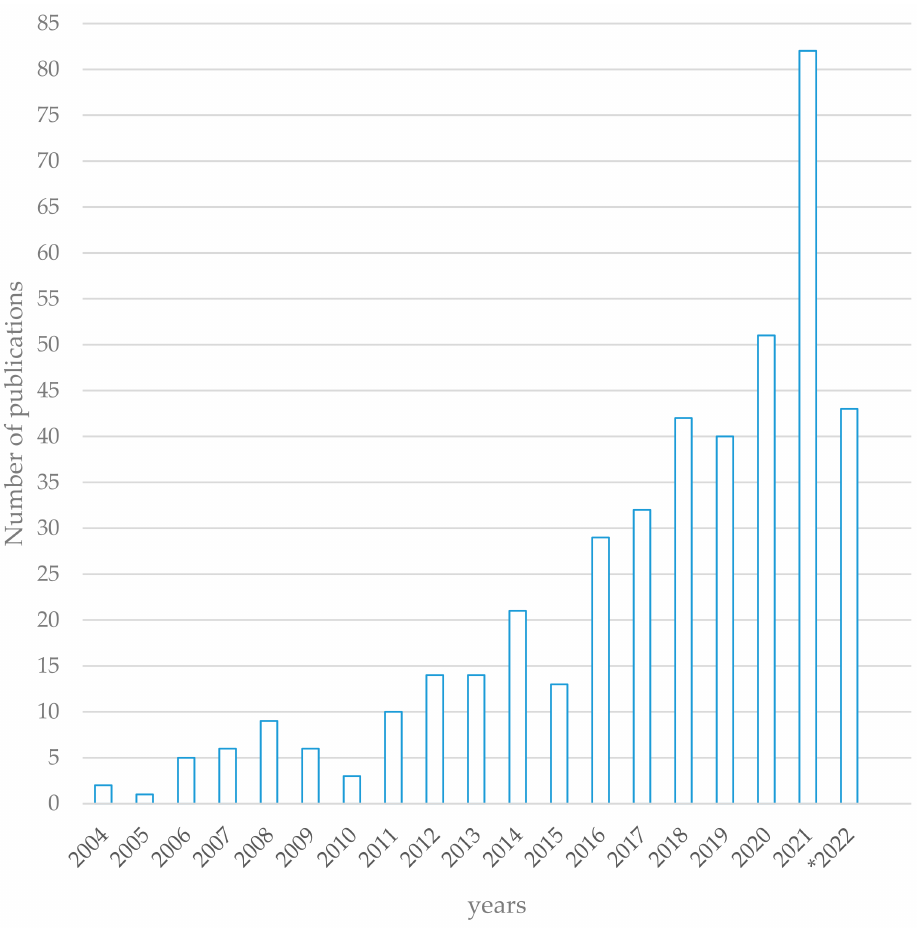
Figure 1. Annual frequency of the publications on multi-storey timber buildings in scientific journals indexed in WoS between 2000 and mid-2022, considering the following sets of keywords: (1) Tall wood building: (2) Multi-storey timber. * The articles considered in 2022 were those published until the beginning of August 2022